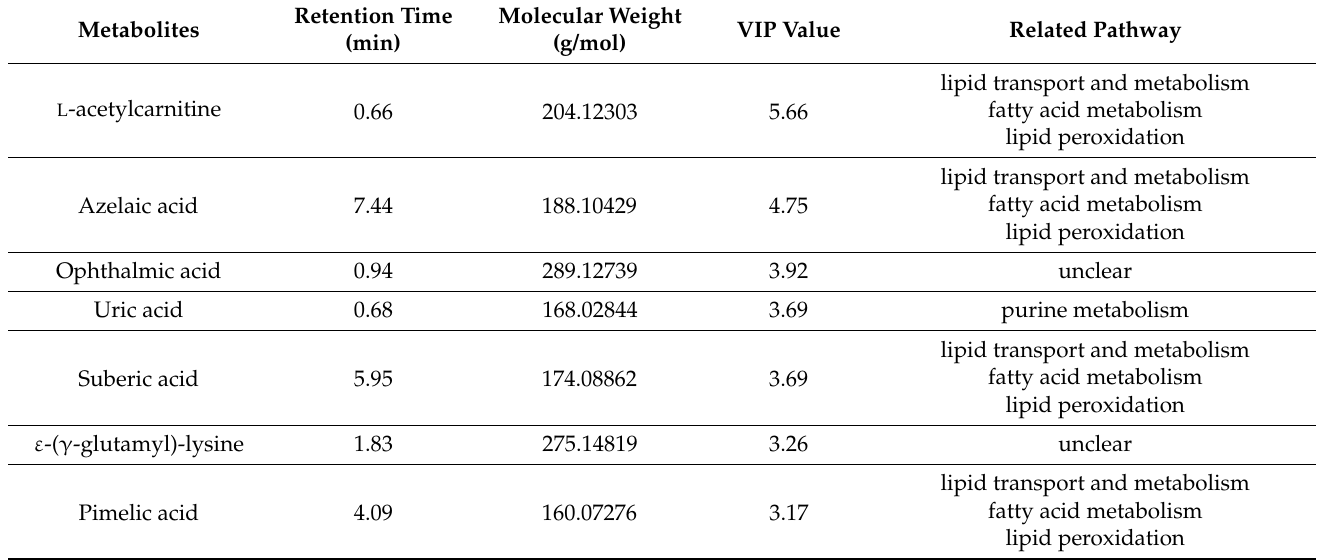
Table 2. The candidates list in the urine samples after single dosing 90 mg DA-9701 after fasting.